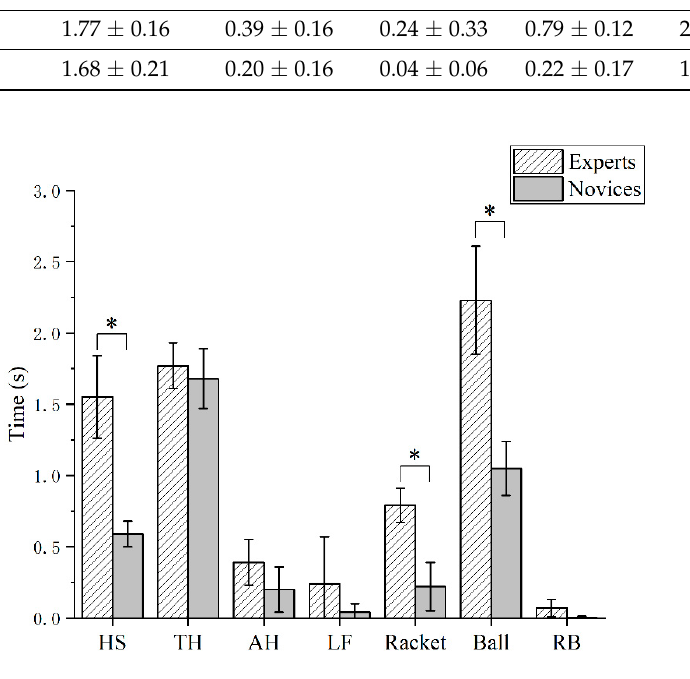
Table 1. Forehand gaze time (average and standard deviation) for tennis players of different skill levels. Head-Shoulder Trunk-Hips Arm-Hand Leg-Foot